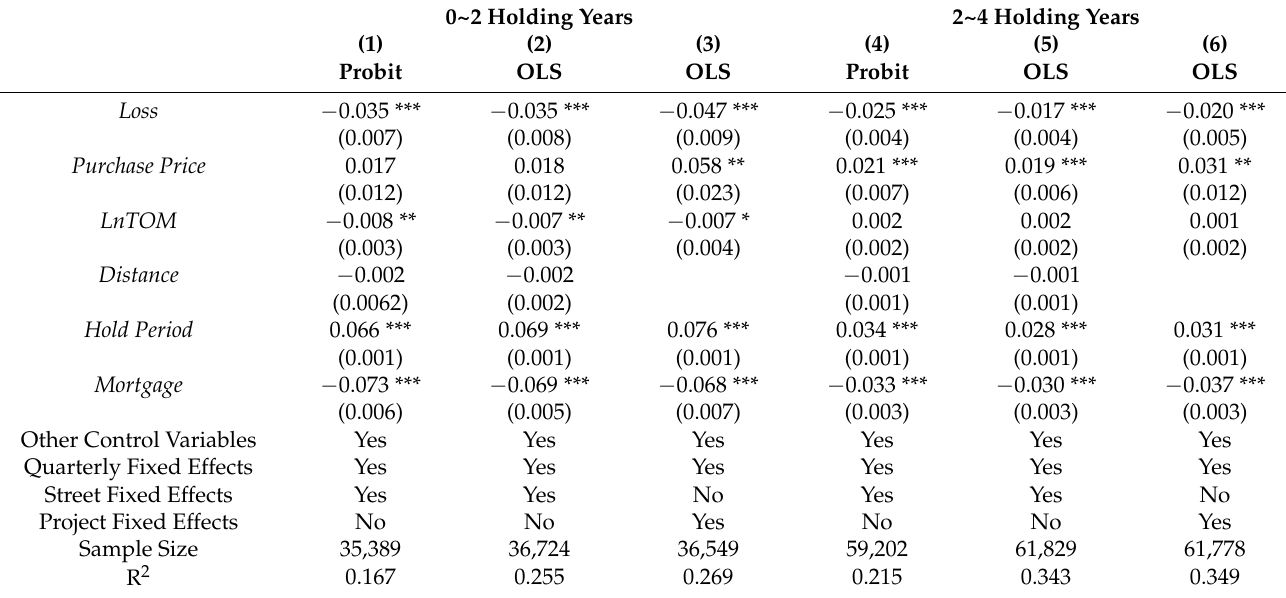
Table 5. Testing results of the disposition